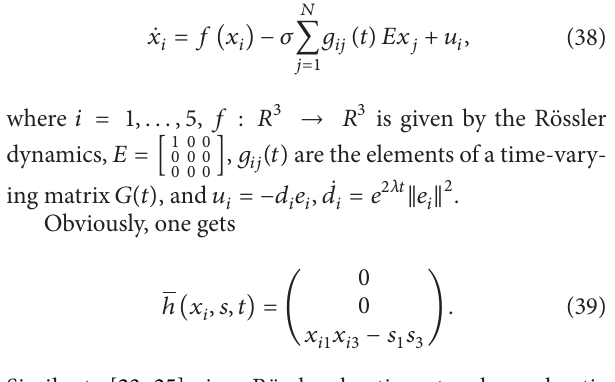
Figure 4: Synchronization errors of 𝑒 𝑖3 for the